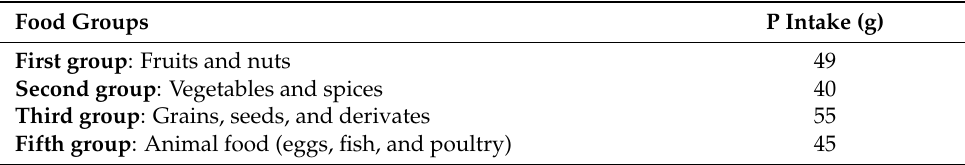
Table 5. Protein intake by food groups.